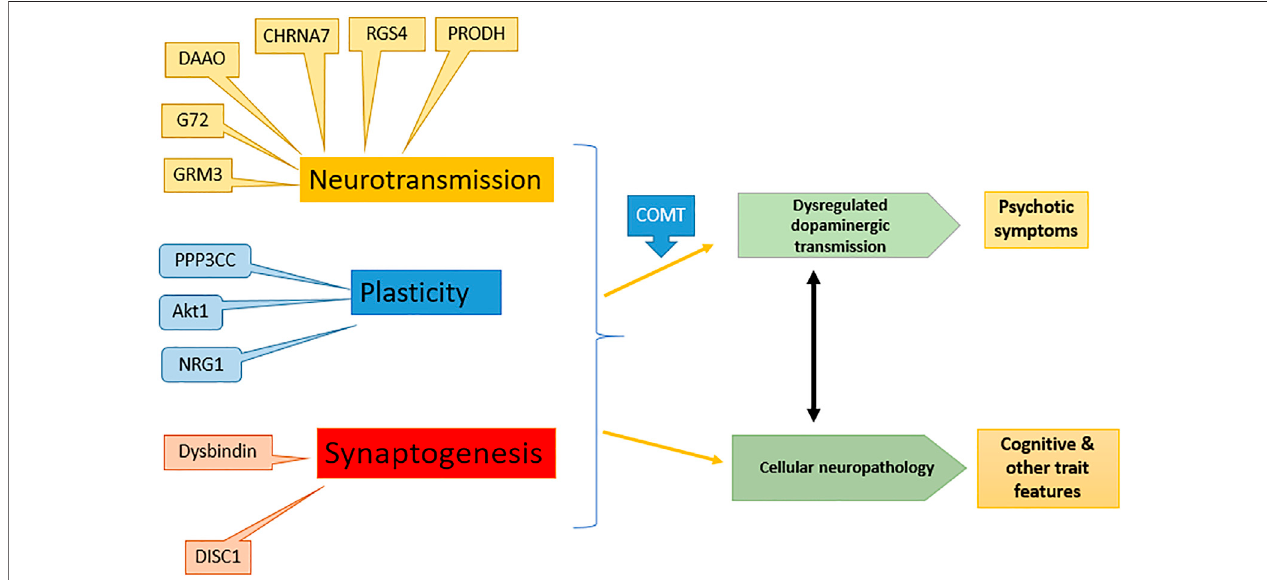
FIGURE1| Effect ofdifferentgenesonsymptomsofschizophrenia:modi fi edfrom (Harrison andWeinberger2005).NRG1,Neuregulin-1; DTNBP1,Dystrobrevin- binding protein 1; DISC1, Disrupted in schizophrenia; DAAO, D -amino acid oxidase; RGSR, Regulator of G protein signaling-4; COMT, Catechol-O-methyl transferase; PRODH, Proline dehydrogenase, G72, D -amino acid oxidase activator.